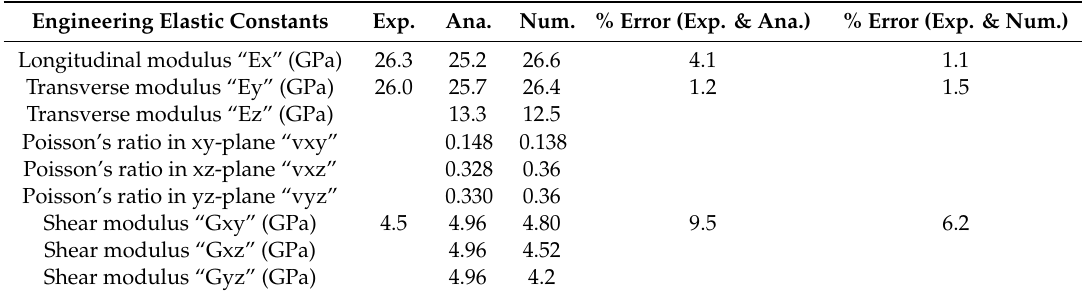
Table 7. Summary of elastic constants